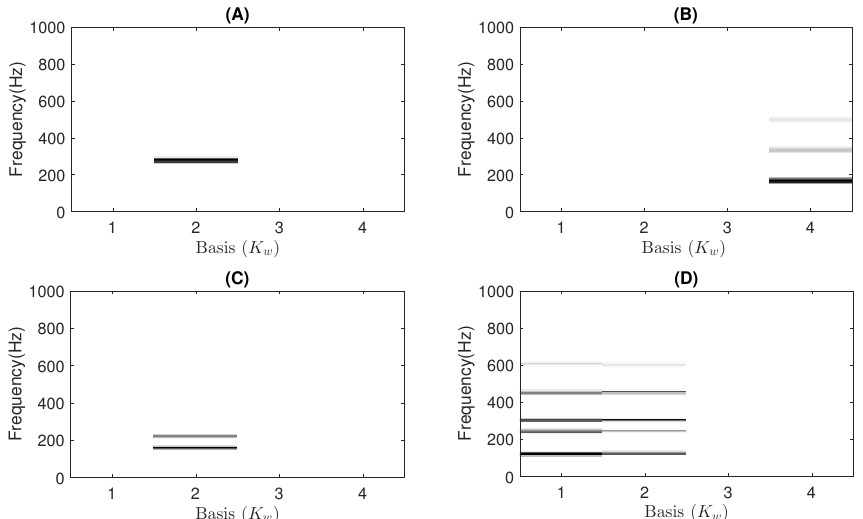
Figure 5. The estimated basis matrices B W obtained from CL-RNMF in the examples shown in Section 1. ( A ) B W for the MP wheezing shown in Figure 1A. ( B ) B W for the MP wheezing shown in Figure 1B. ( C ) B W for the PP wheezing shown in Figure 2A. ( D ) B W for the PP wheezing shown in Figure 2B. The wheezing spectral patterns were compacted into a single basis, B W ( 2 ) (in Case ( A )), B W ( 4 ) (in Case ( B )), and B W ( 2 ) (in Case ( C )). However, the energy of the narrowband spectral peaks was divided into two bases B W ( 1 ) and B W ( 2 ) , as can be seen in Case ( D